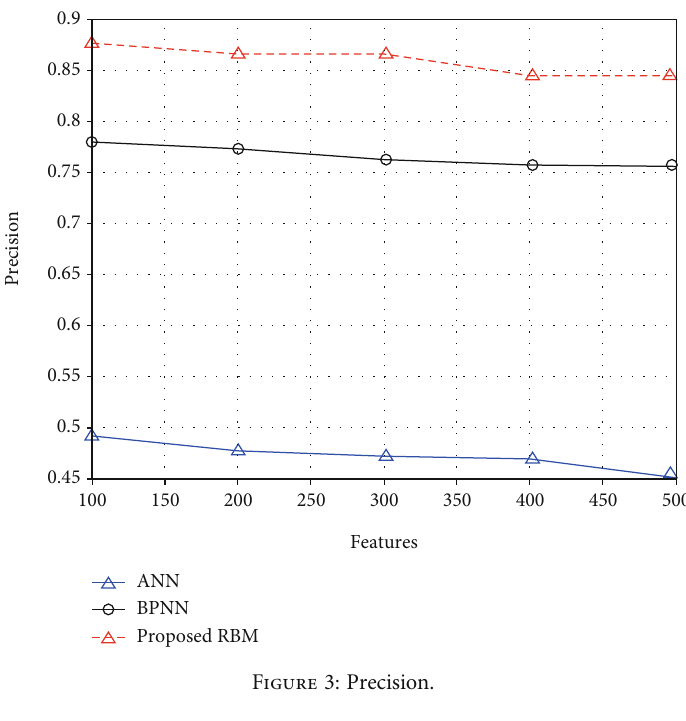
Figure 3: Precision.